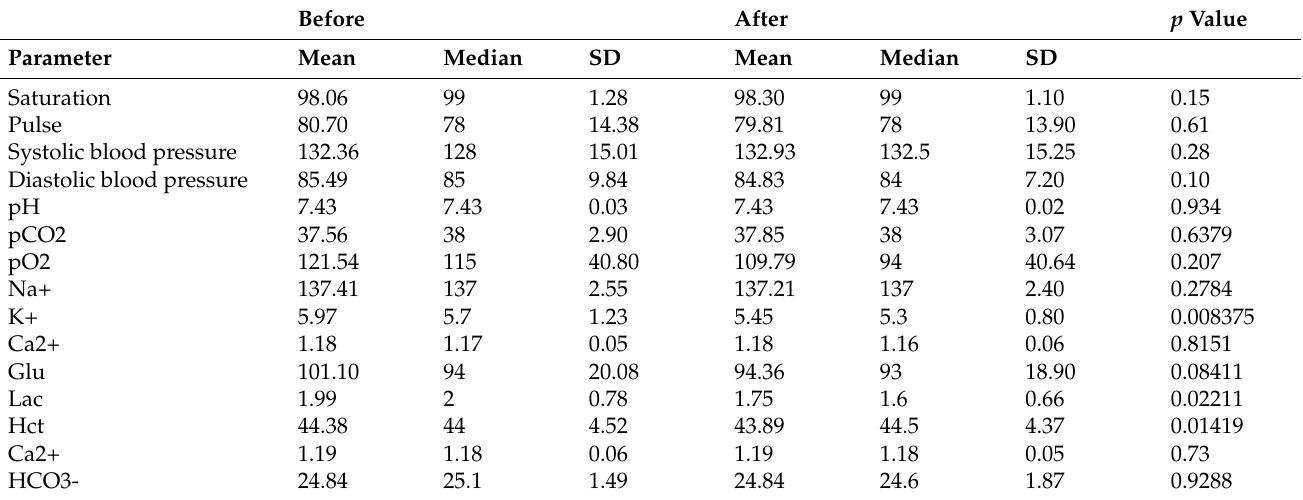
Table 6. Results of the blood gas examination and basic parameters of the FFP2 mask using the Wilcoxon signed-rank test. A p value < 0.05 was considered statistically significant. Statistically significant results are shown in